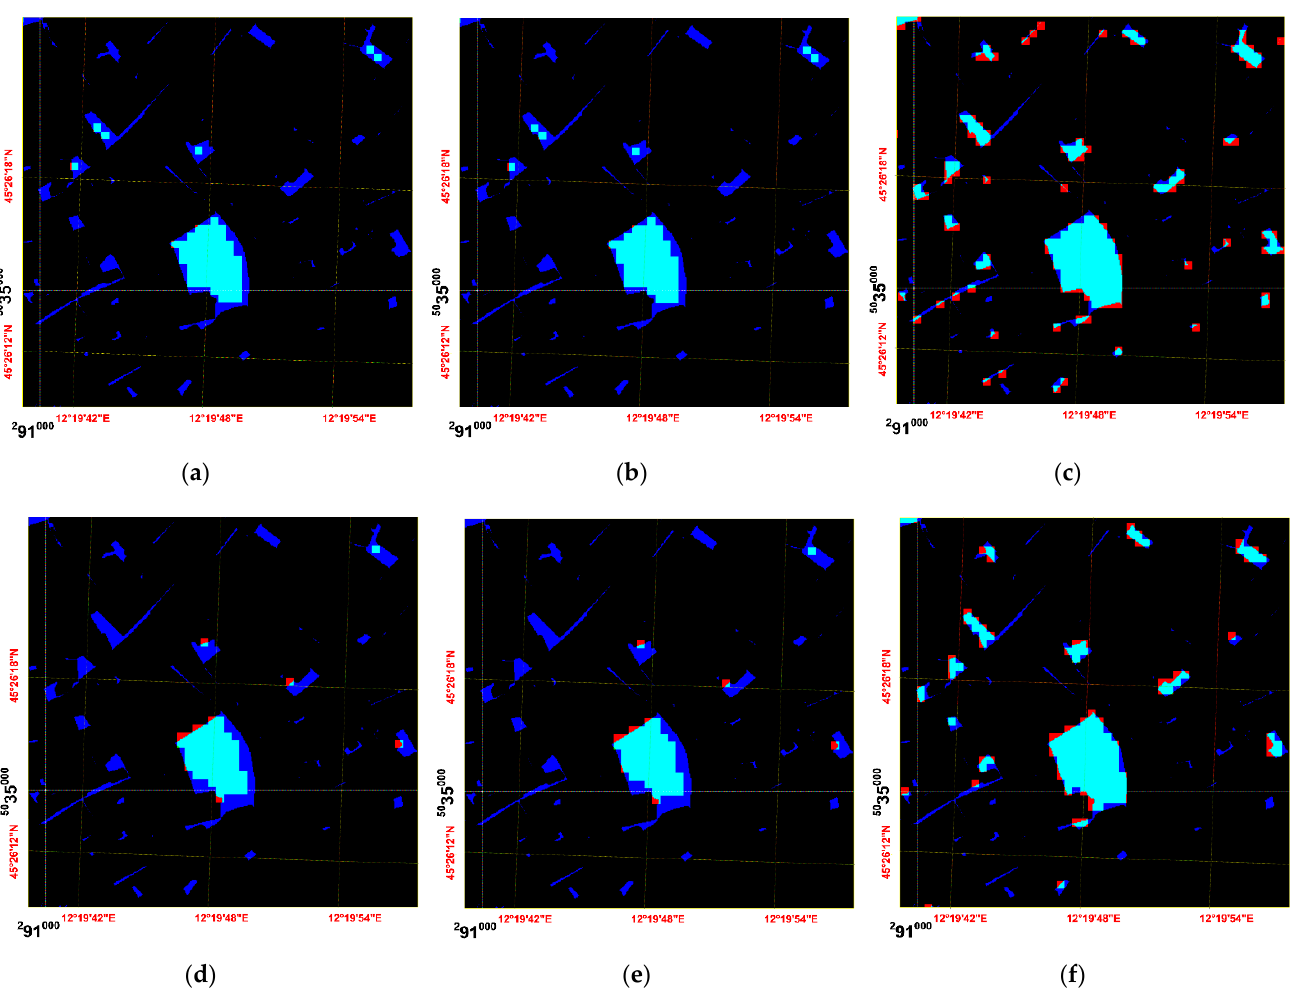
Figure 6. Comparison of image-resampling methods; first, methods used to resample the reference mask from 0.20 to 8 m, and second, those used to resample from 8 to 0.20 m: ( a ) first, the nearest neighbor method and, second, the bilinear convolution method were applied; ( b ) first, the nearest neighbor method and, second, the cubic convolution method were applied; ( c ) first, the nearest neighbor method and, second, the nearest neighbor method were applied; ( d ) first, the pixel aggregate method and, second, the bilinear convolution method were applied; ( e ) first, the pixel aggregate method and, second, the cubic convolution method were applied; ( f ) first, the pixel aggregate method and, second, the nearest neighbor method were applied.